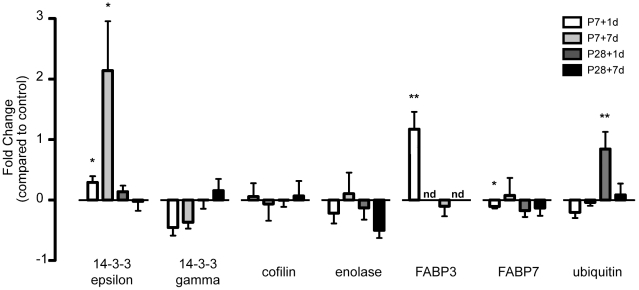
Expression values of genes validated by qRT-PCR at P7 and P28, 1 and 7 days after injury.Genes validated were 14-3-3 epsilon, 14-3-3 gamma, cofilin, enolase, ubiquitin and the fatty acid binding proteins 3 and 7 (FABP3, FABP7). Bars represent fold change normalized to age-matched controls with standard error of mean. Positive values represent up-regulation while negative values represent down-regulation. Mann-Whitney nonparametric statistical tests were used to show significance. Abbreviations: nd, (gene of interest) not detected; *, p>0.05–<0.10; **, p<0.05.